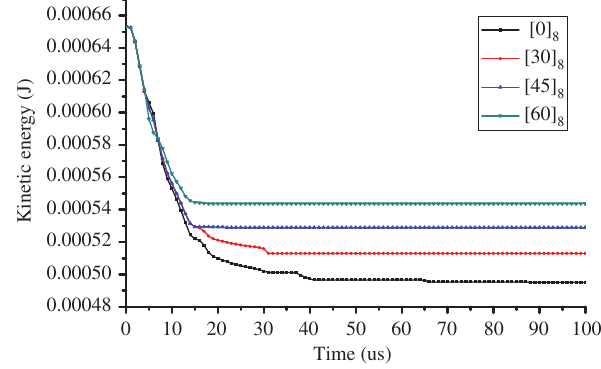
Figure 4: Bullet kinetic energy reduction-time curves for target plates with different thicknesses.